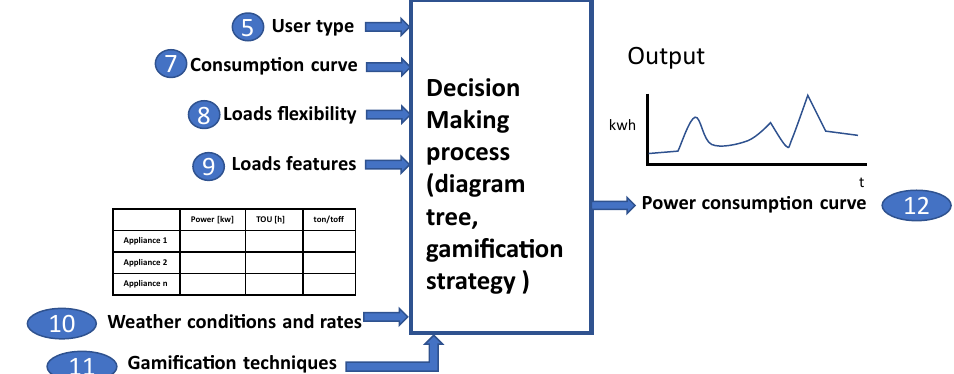
Figure 6. Diagram of Step